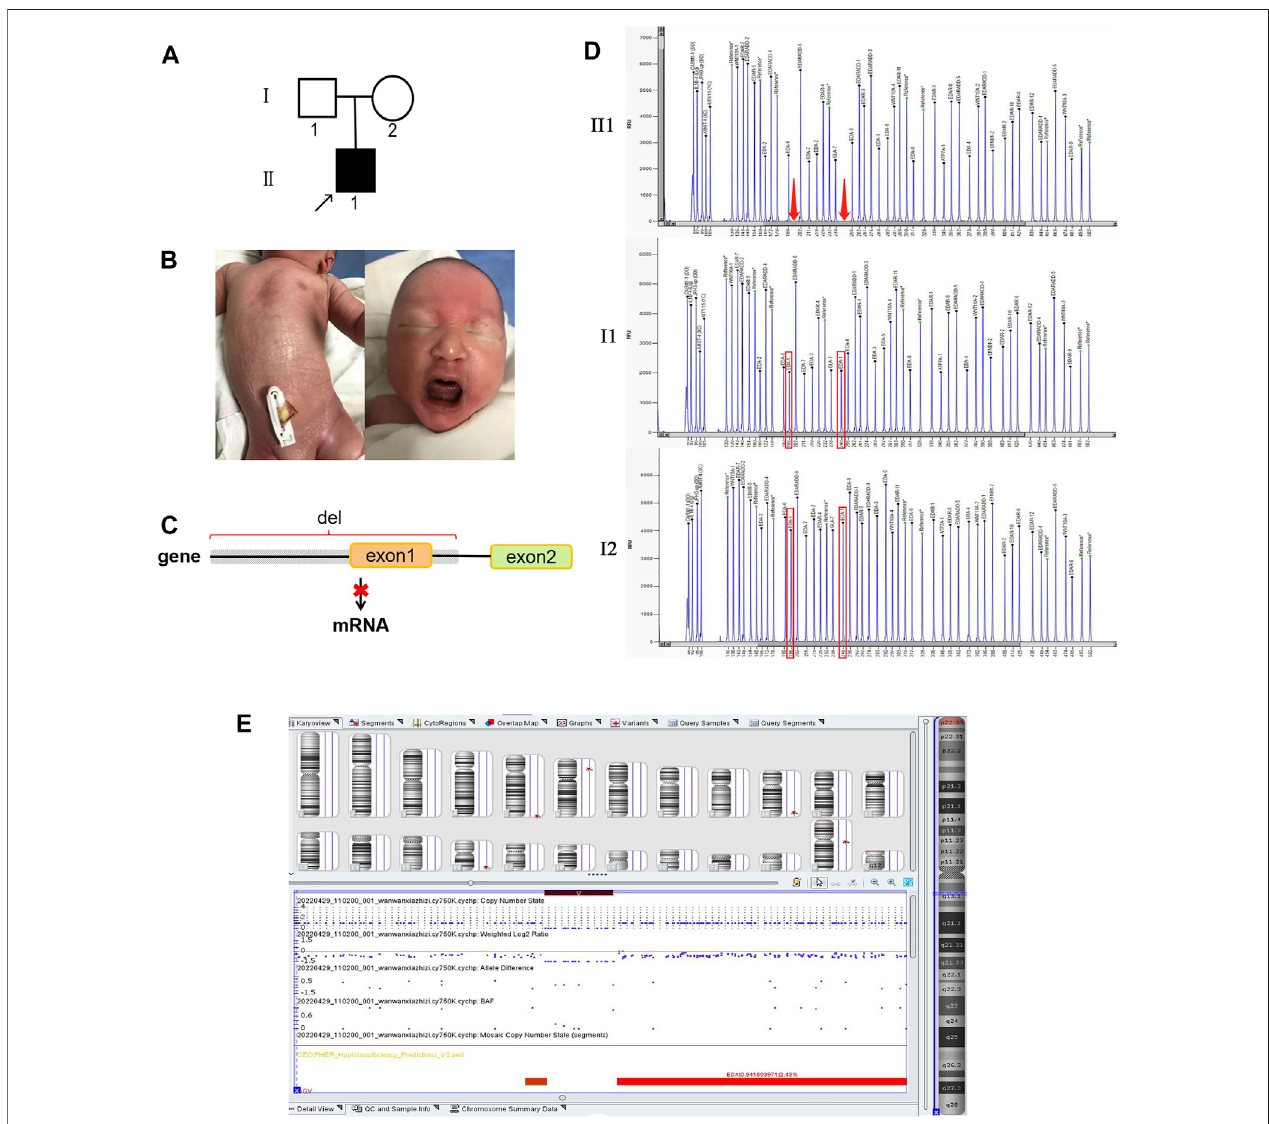
FIGURE3 | Variantsin case 3. (A) Family tree showing a de novo mutation. (B) Dry skin ofproband 3. (C) Transcriptionpattern. (D) MLPA results show deletion of exon 1. (E) CMA pro fi le showing a loss of 82 kb of Xq (chrX: 68,831,364 – 68,748,640; hg19) (dark red box) which isupstream of the EDA gene. Images were generated using the Chromosome Analysis Suite (ChAS)